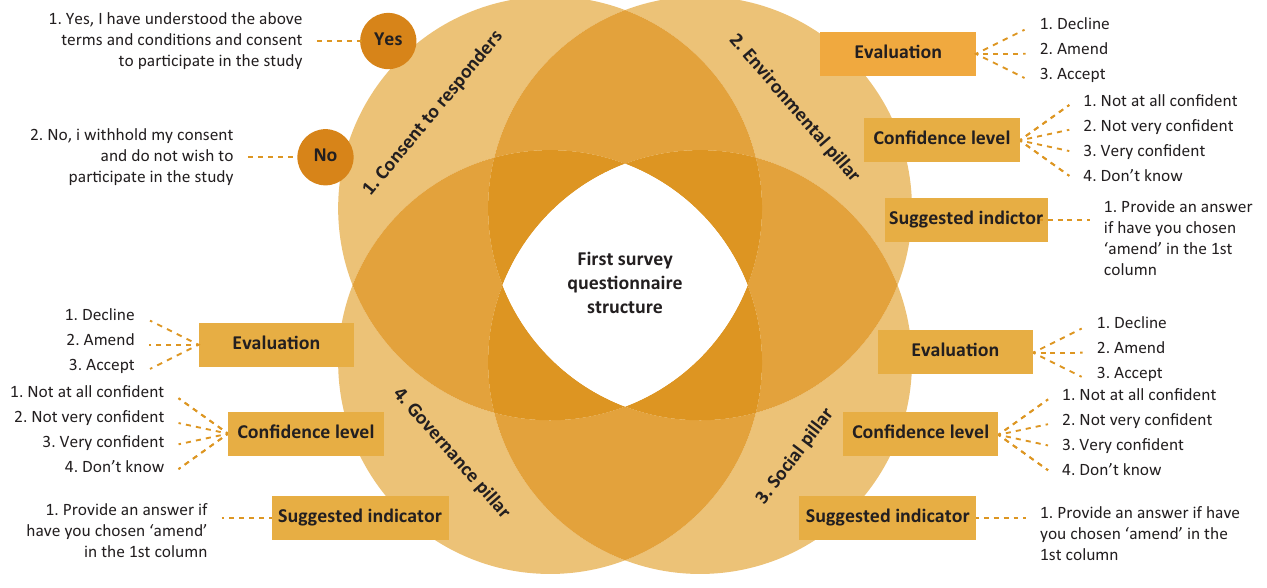
FIGURE 1: Matrix format – first round